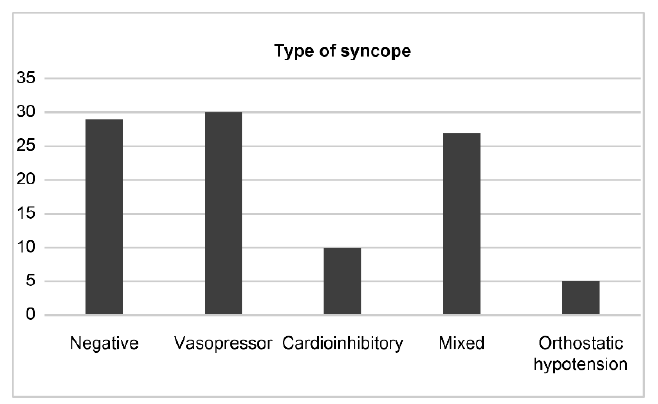
Figure 2. HUTT results are classified according to the NMS type. Negative included the patients who did not presented with syncope during HUTT.